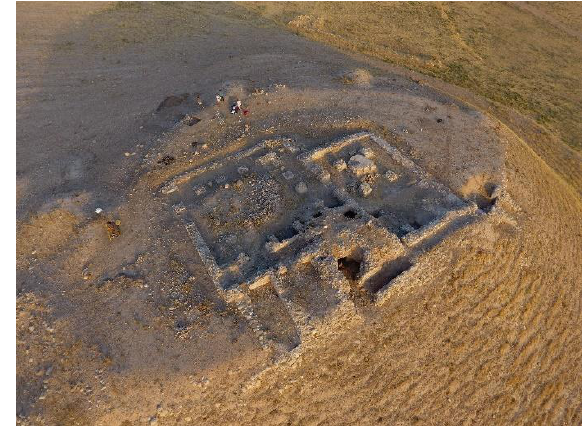
Figure 5. An aerial view of the Qala Shila archaeologic site, DJI Phantom 4